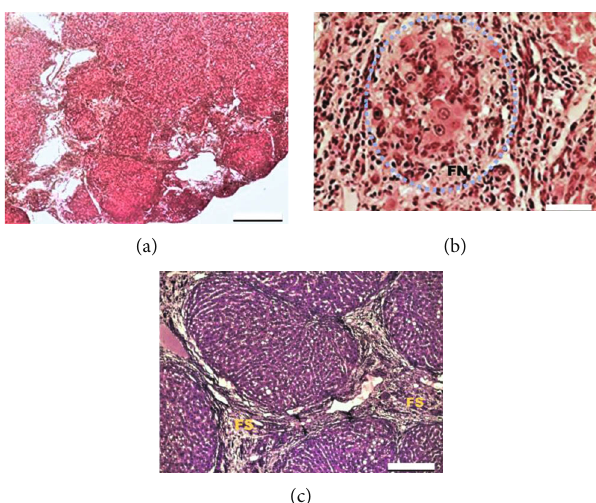
Figure 4: Representative photographs of liver of group G-II. (a) Chronic fi brosis, H&E staining. (b) Fibrotic nodule (FN), H&E staining. (c) Fibrosis septa (FS) by Masson ’ s staining. Bar length = 400 μ m (a), 50 μ m (b), and 200 μ m (c).